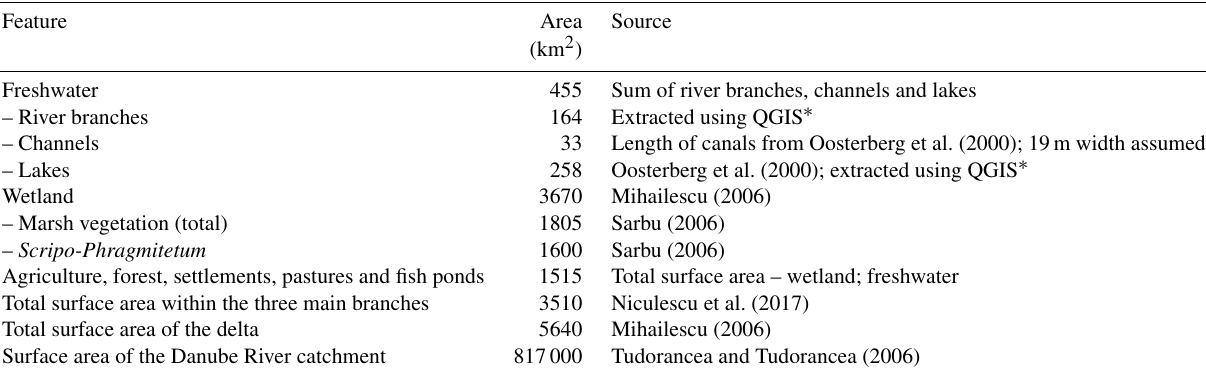
Table 1. Surface area of the Danube Delta features. Assuming a 19m channel width means the estimation of the surface area of the channels is on the lower end. The surface areas of freshwater and wetland do not add up to the total area since parts of the delta are covered by forest and agricultural